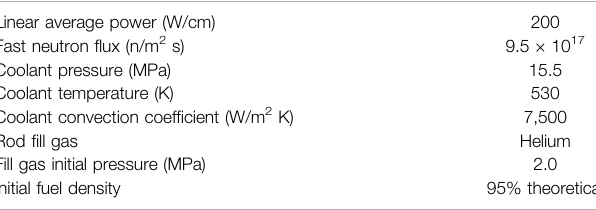
TABLE 1 | Input parameters for the axisymmetric problem under typical PWR operating conditions (Liu et al., 2015). Linear average power (W/cm)